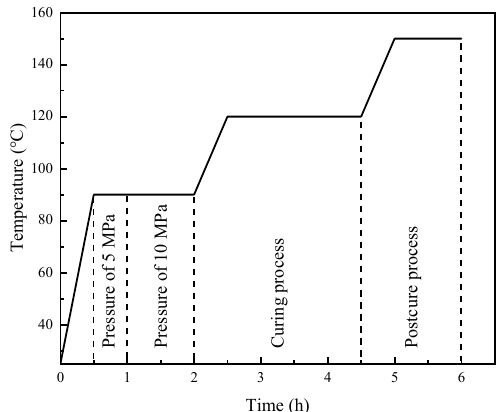
Figure 9. Schematic view of manufacturing toughened composite laminates.